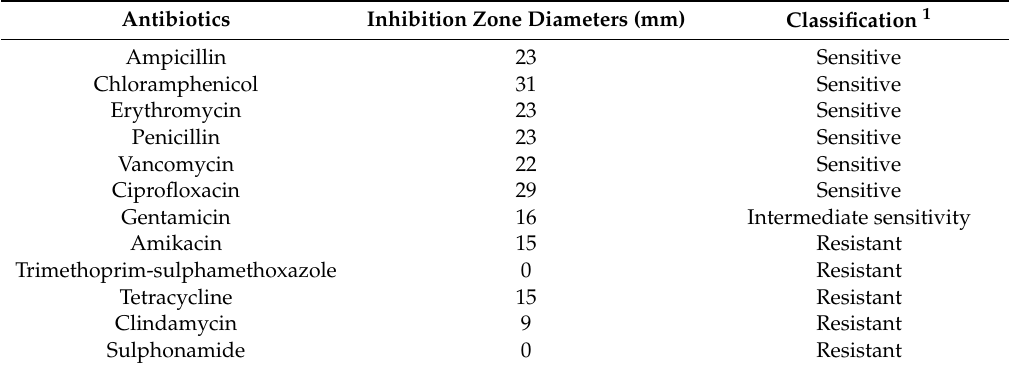
Table 4. Antibiotic susceptibility of Lactococcus lactis subsp. cremoris LL95.